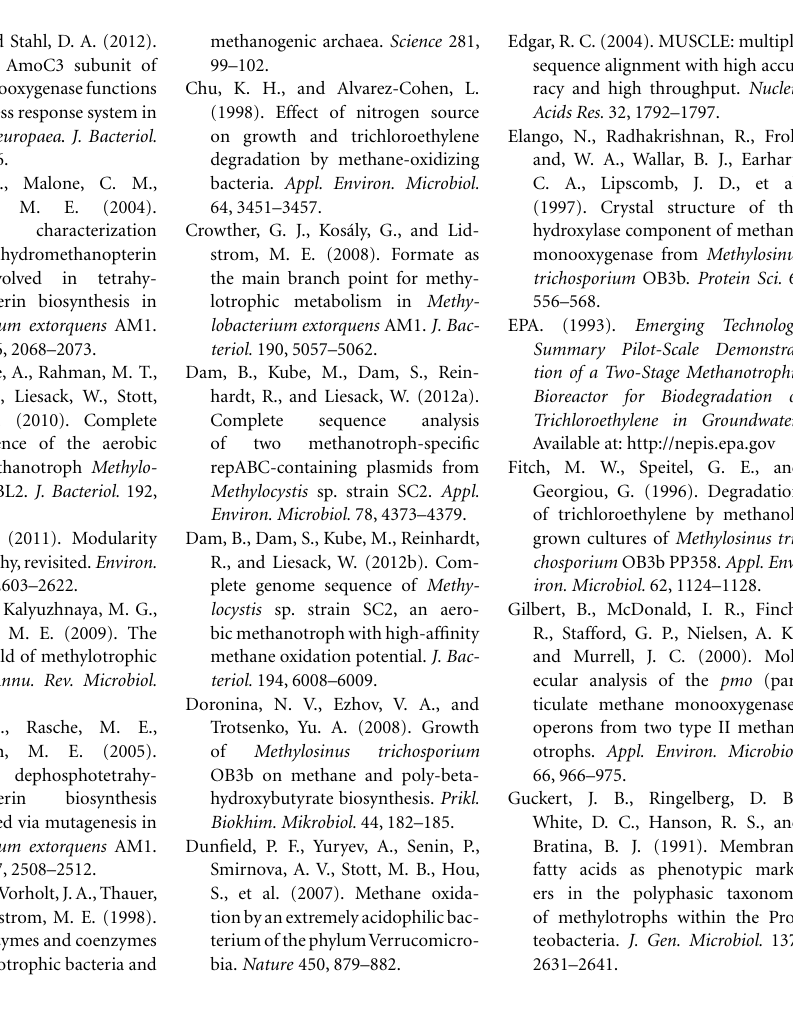
Figure S1 | RNA-Seq reads mapped per base relative to start of pmo-operon. Left, the average number of reads mapped to the region − 330 to − 270 upstream from the start of pmoC for two biological replicates.The sequence at each base is shown above the bars. Right, the range (shown in red) and mean of two biological replicates (shown as black line) for the number of reads mapped per base for the coding and downstream region of the pmo -operon. Figure S2 | Genetic organization and relative expression (RPKM) of the mxa gene cluster (A), the pqq gene cluster (B) and cluster of genes encoding reactions of the H 4 MPT-linked C1 transfer pathway (C). Figure S3 | RNA-Seq reads mapped per base relative to start of mxaF ORF. Left, the average number of reads mapped to the region − 200 to − 140 upstream from the start of mxaF for two biological replicates.The sequence at each base is shown above the bars. Right, the range (shown in red) and mean of two biological replicates (shown as black line) for the number of reads mapped per base for the coding and downstream region of the mxaF cluster. Figure S4 | RNA-Seq reads mapped per base relative to start of serine cycle gene operon. The log10 average number of reads mapped at each base from biological replicates one and two is shown. In (A) , the upstream location spanning − 250 to − 190 from putative start of ftfL. (B) The expression over the entire operon. Note the several drop to near zero upstream indicating the operon is not co-transcribed. (C) The − 230 to − 170 region upstream from sga.